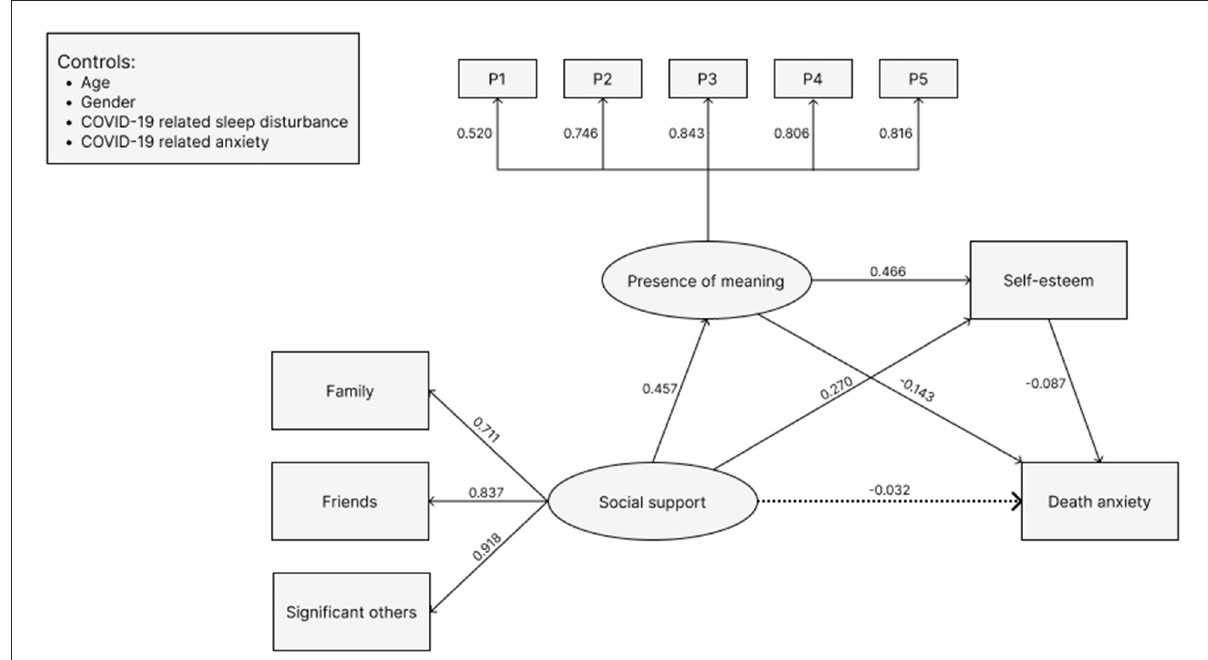
FIGURE2 Final model for the whole sample ( N = 1167), with standardized bate weights. Fit index: x 2 = 243.384, df = 58, p < 0.001; CFI = 0.968, TLI = 0.954, RMSEA = 0.052, SRMR = 0.044. Circles indicate latent variables, while rectangles represent observed variables. Solid lines indicate paths are statistically significant while dashed line indicate paths are noit statistically significant. Abbreviations: Items P1–P5 measure presence of